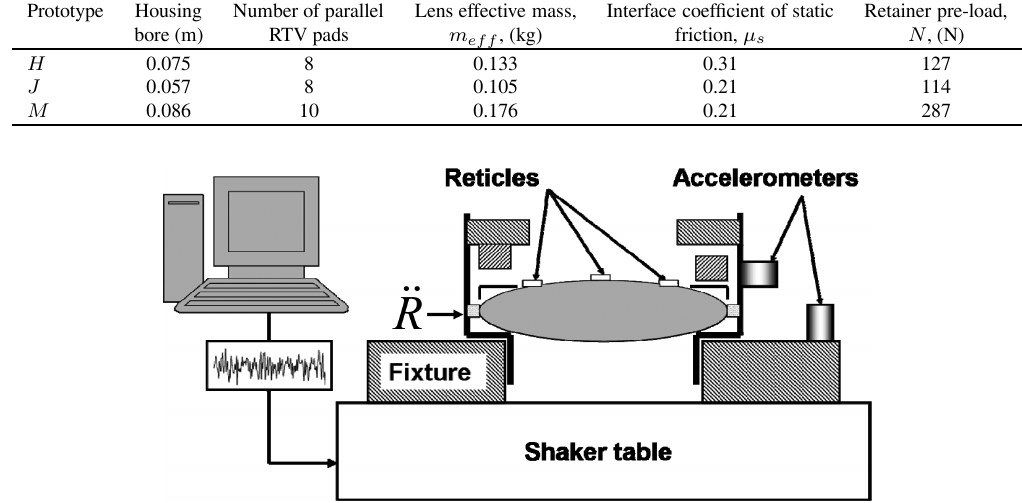
Table 1 Prototype parameters for sub-assembly random vibration test